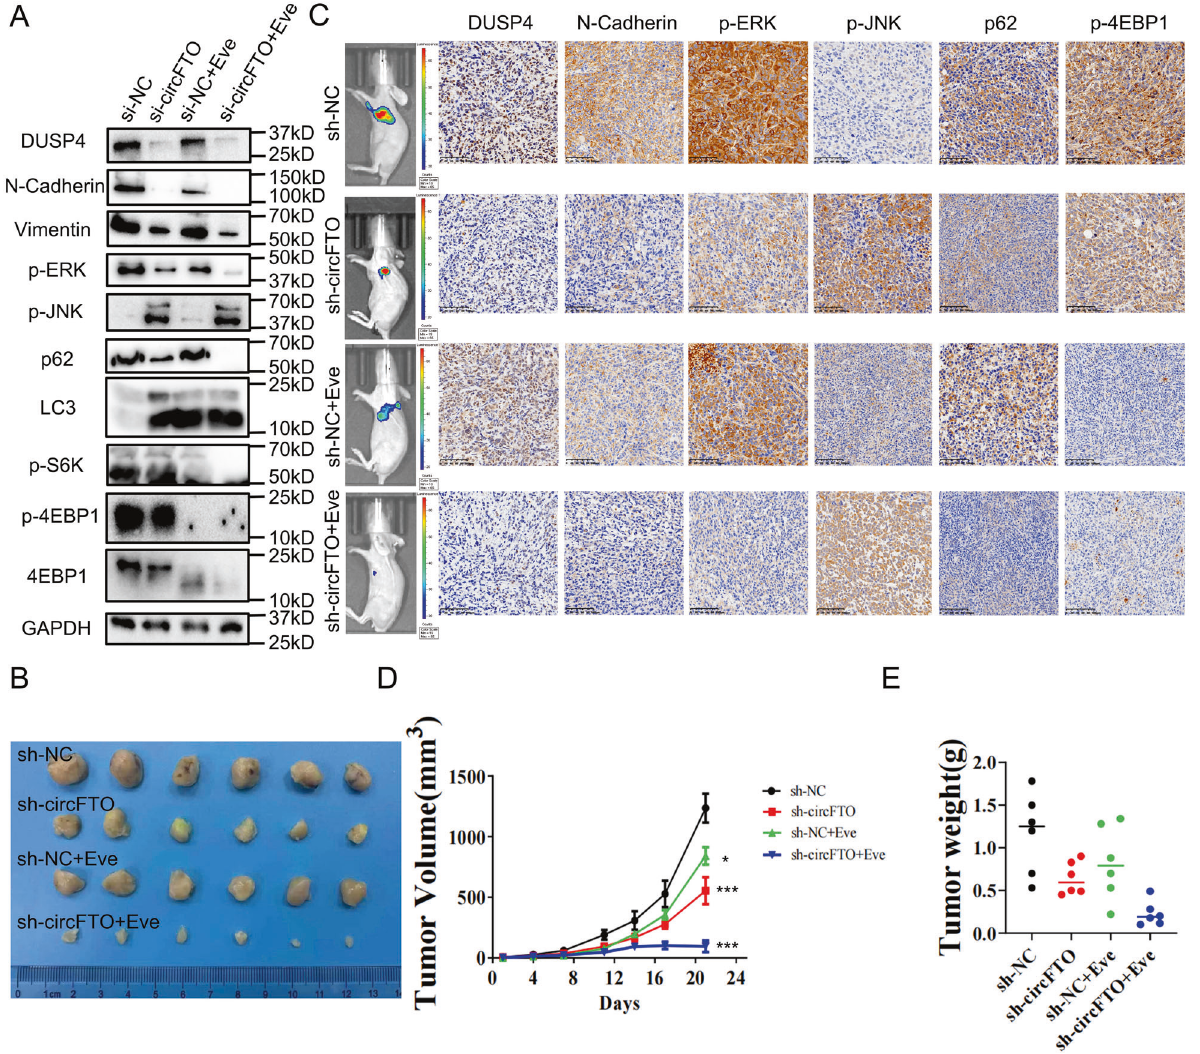
negative control/Everolimus. B Images of eviscerated tumors of subcutaneous xenografts of sh-NC and sh-circFTO 786-O cells co-treated with negative control/Everolimus. C IHC of the eviscerated tumors after sacri fi ce of mice con fi rmed the results from Western Blot. D and E Tumor volumes and weights were also